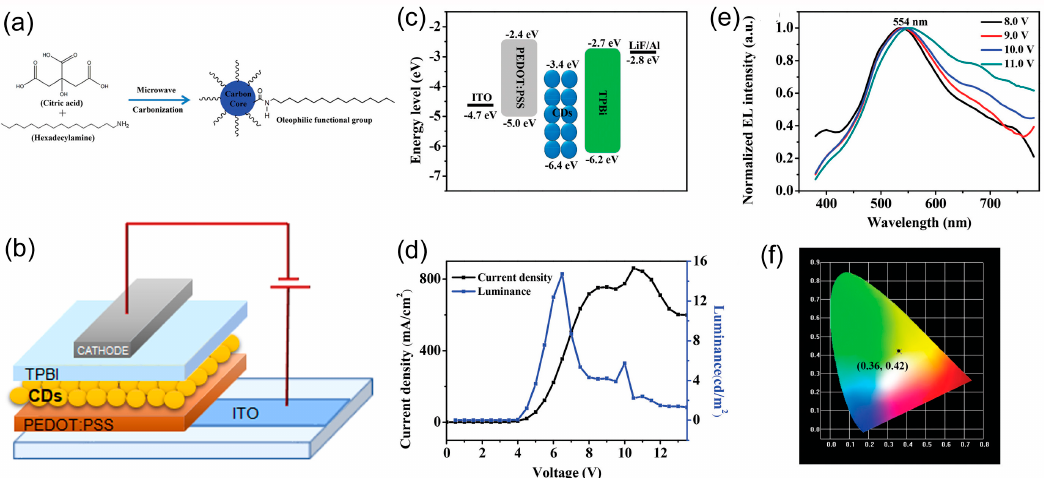
Figure 14. ( a ) Illustration of the route for the synthesis of CDs, ( b ) schematic representation of the device architectures, ( c ) energy level diagram of the CD-LED, ( d ) J – L – V characteristics curve of the CD-LED, ( e ) normalized EL spectra of the CD-LED at different driving voltages, ( c ) current density–voltage–luminance ( J – L-V ) characteristics curve of the CD-LED, and ( f ) CIE coordinates of the CD-LED at the working voltage of 10.0 V: reproduced with permission from [76], copyright 2018 The Royal Society of Chemistry.